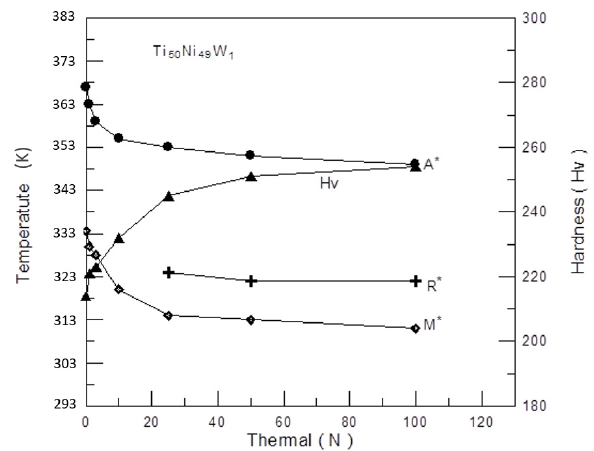
Figure 5. Austenite peak temperature ( A *), martensite peak temperature ( M *), R-phase peak temperature ( R *), and hardness of the Ti 50 Ni 49 W 1 alloy as a function of the number of thermal cycles.